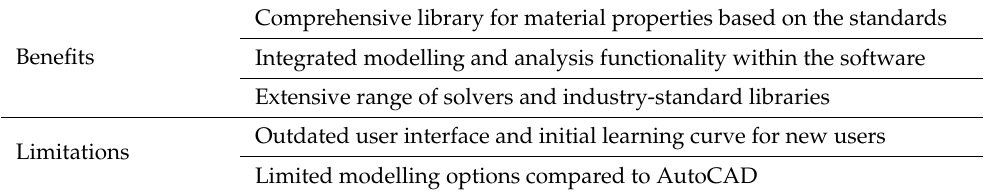
Table 2. Benefits and limitations of Strand7.